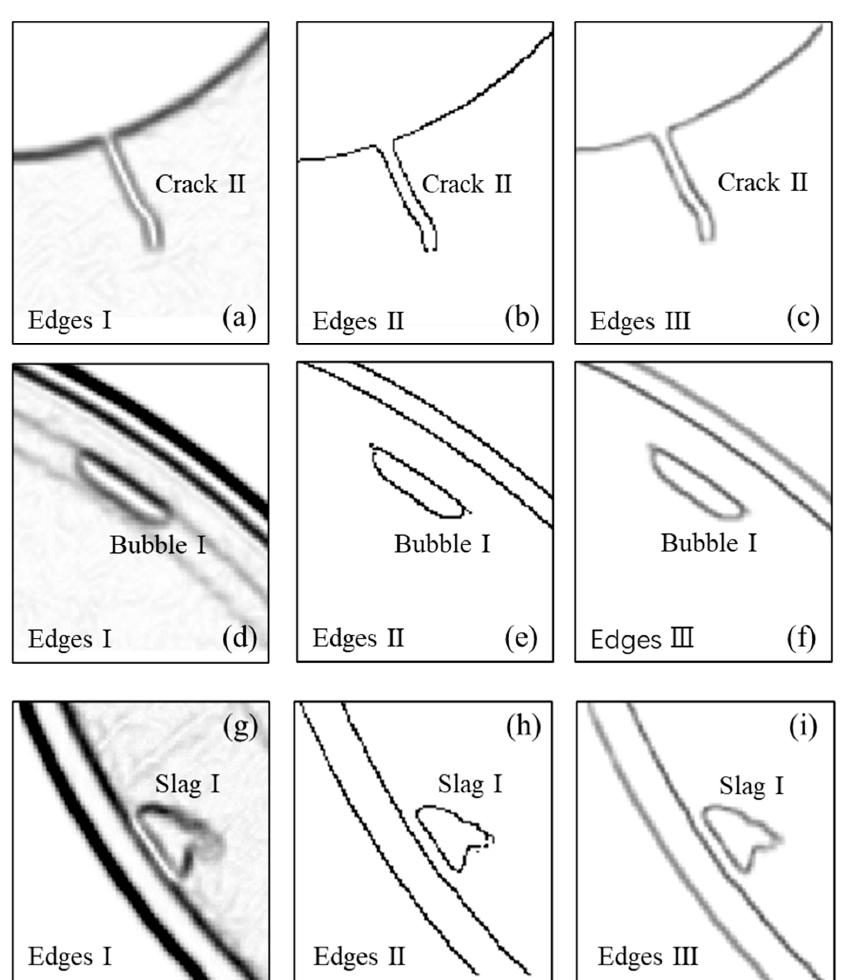
Figure 6. Various types of edges with typical defects: ( a – c ), type I, II, and III edges of Crack II; ( d – f ), type I, II, and III edges of Bubble I; ( g – i ), type I, II, and III edges of Slag I.